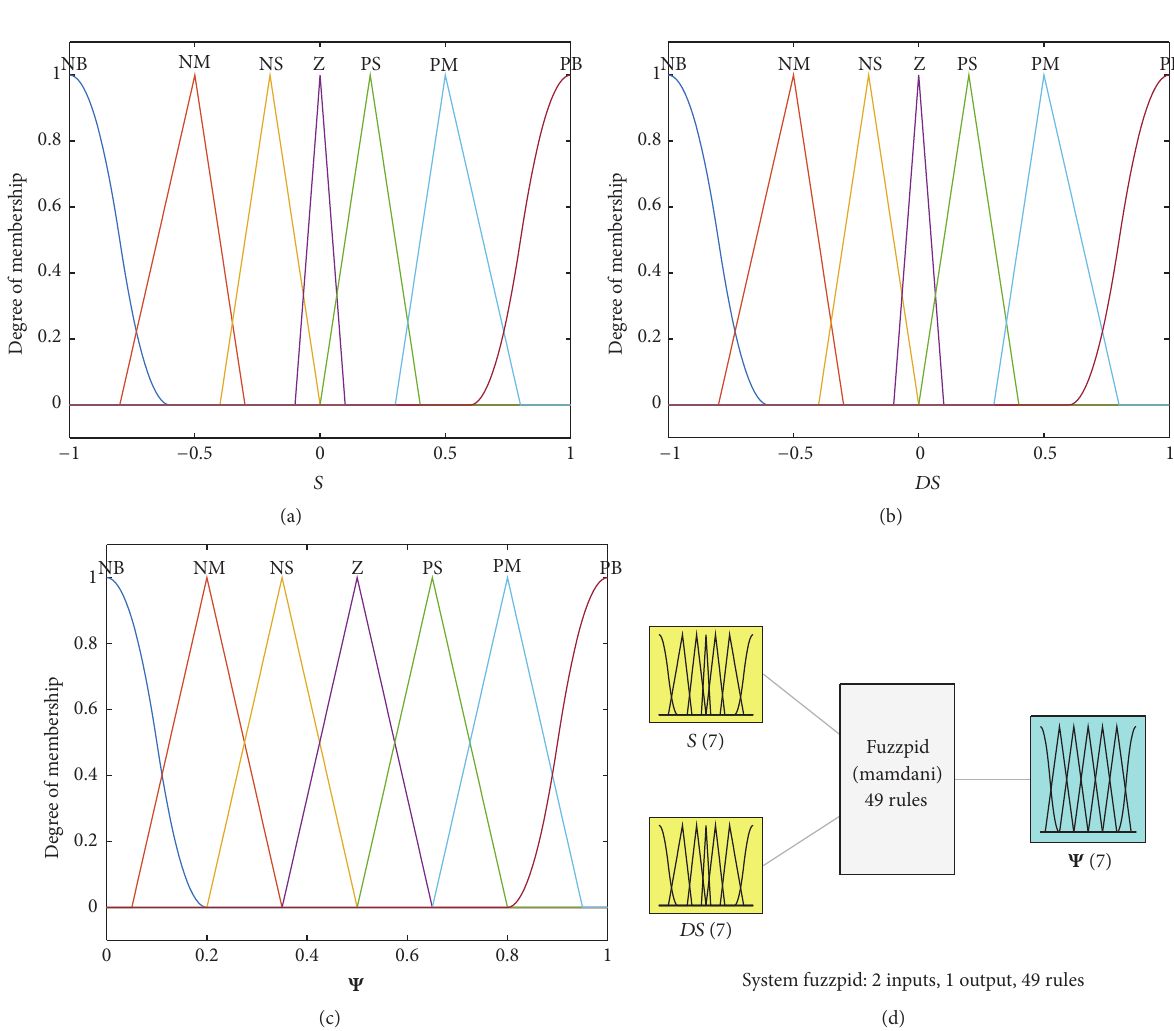
Figure 6: Membership functions of fuzzy controller ((a) linguistic variable 𝑆 ; (b) linguistic variable 𝐷𝑆 ; (c) linguistic variable Ψ ; (d) schematic of fuzzy